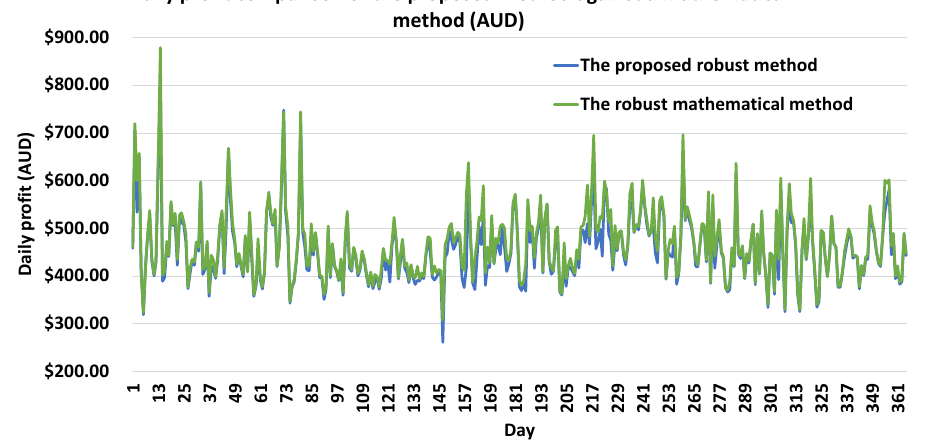
Figure 12. The daily profit comparison between the proposed robust method and the mathematical robust method for participating in the energy market only.